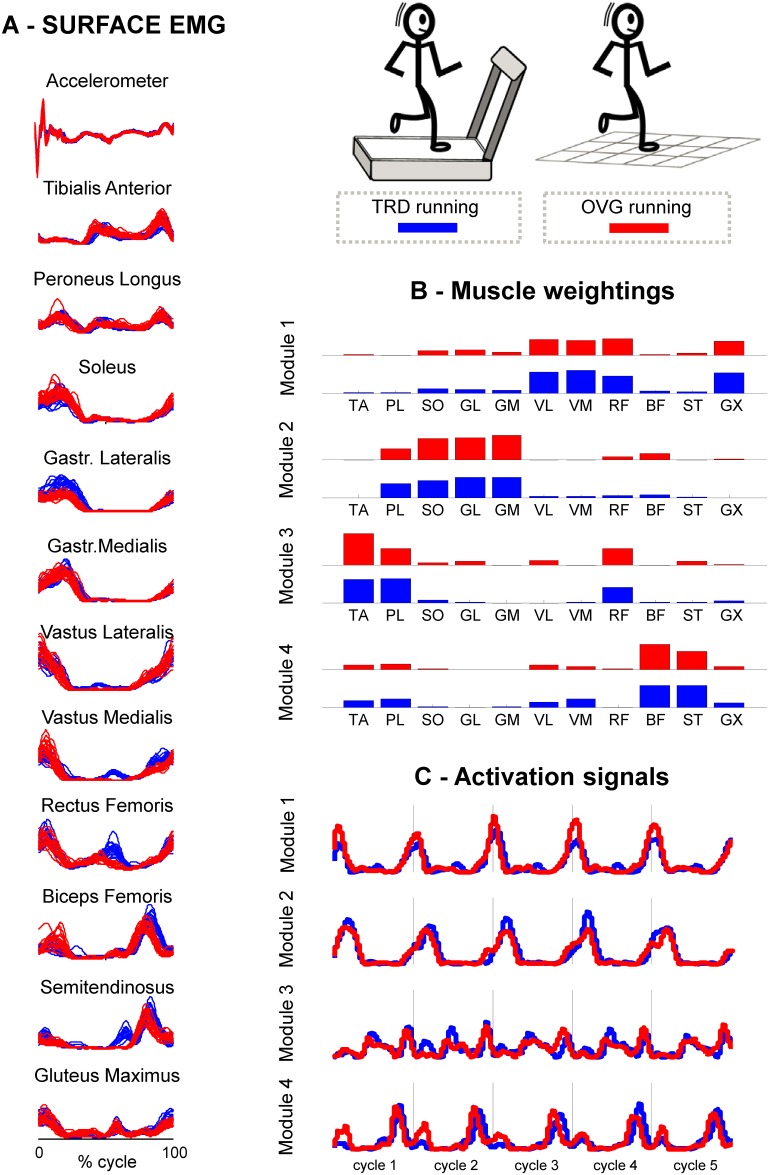
Experimental design.Illustration of experimental design involving treadmill (blue) and overground running (red) from a representative subject. Tibia vertical acceleration used to identify gait cycles, and surface EMG are plotted in (A) (raw data for acceleration, envelope for sEMG). The gait cycles were defined from one left foot strike to the following left foot strike. The motor modules extracted from the concatenated surface EMG are represented as “muscle weightings” (panel B) and “activation signals “(panel C), in this case 5 consecutive gait cycles are reported. It is worth noting that by concatenating several gait cycles we accounted the inter-cycle variability in the analysis.